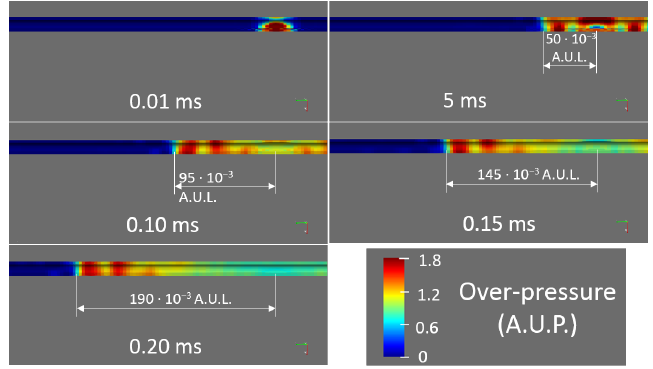
Figure 5. Representation of the fluid pressure field in the main section at different time steps. Approximate distances are indicated to show the figure scale. For the sake of clarity, the structure is not shown.